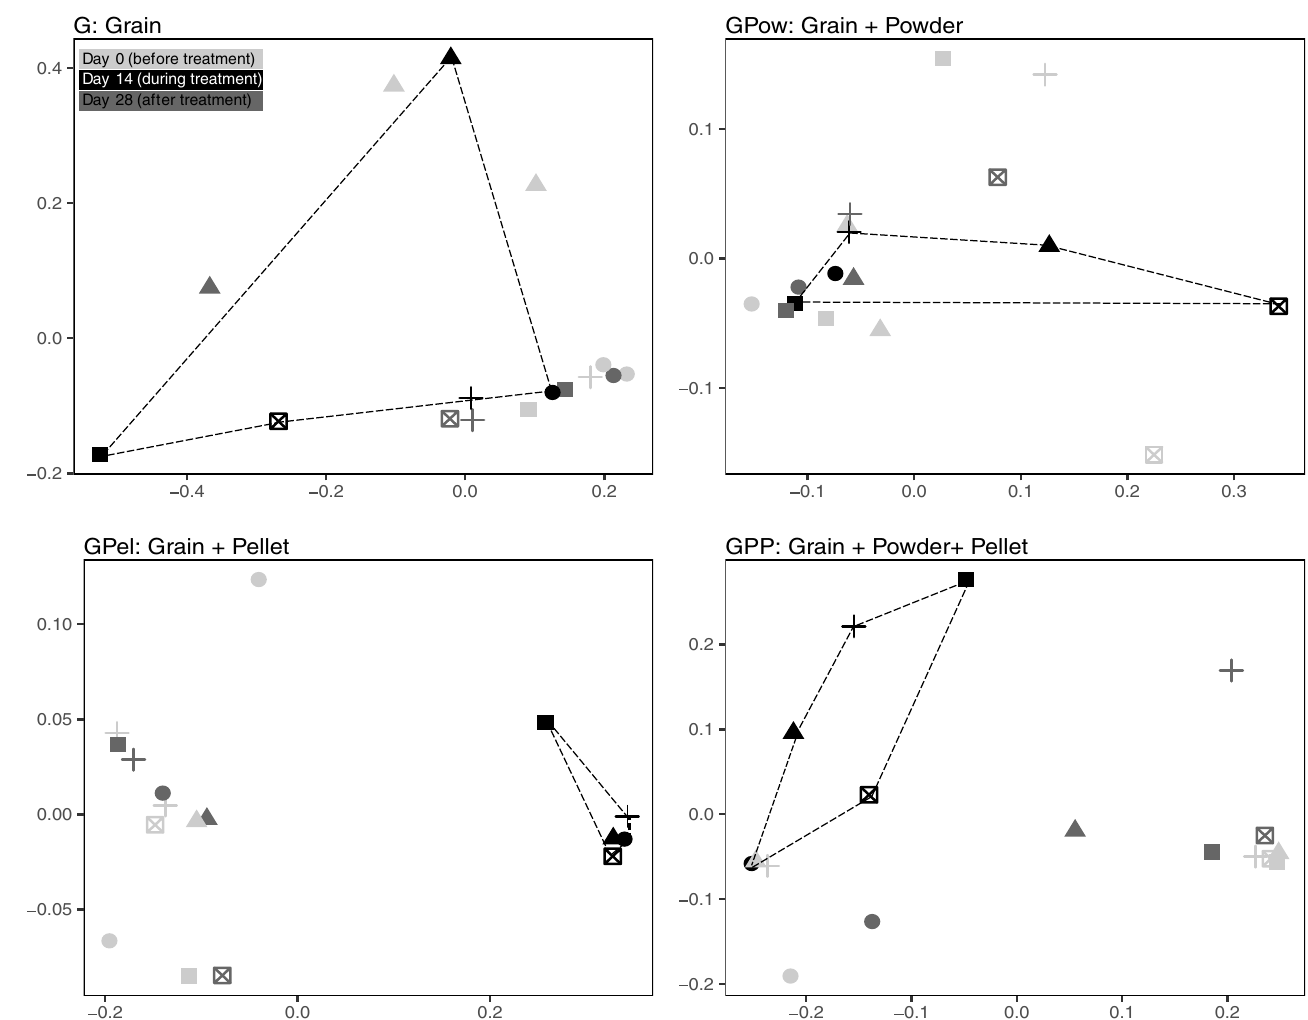
Fig 5. Non-multidimensional Scaling (NMDS) of weighted UniFrac distances from fecal microbiomes of domesticated Birmingham Roller pigeons. Samples collected before treatment (Day 0; Light grey), at the end of the treatment period (Day 14; Black), and two weeks post-treatment (Day 28; Dark grey). Symbols represent different individuals within the treatment. Lines connect the samples collected at day 14. Powder and Pellet refer to two different probiotic supplements the pigeons received during the treatment period.